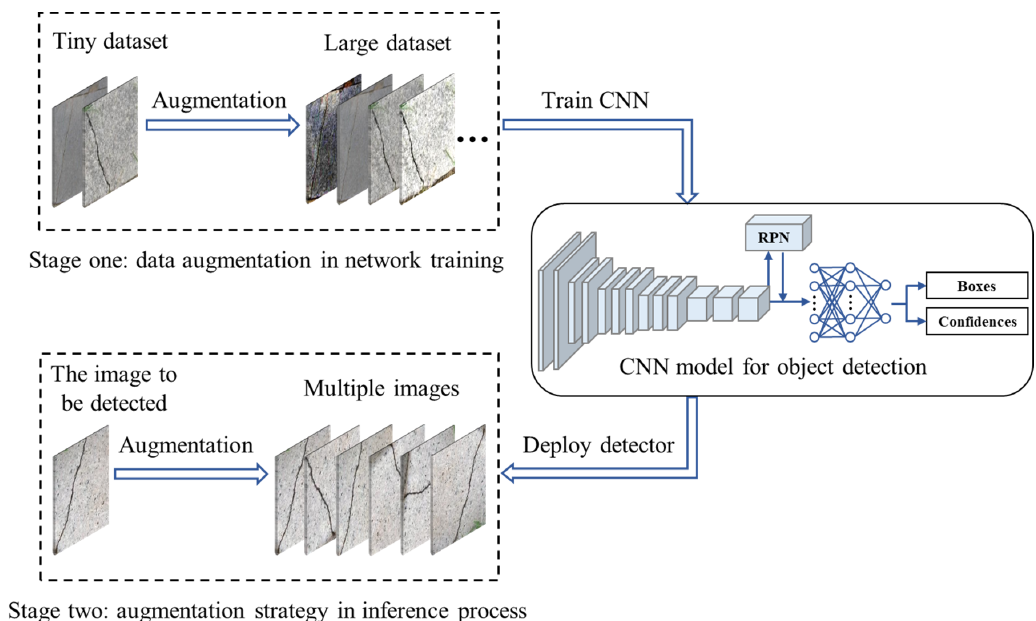
Figure 1. The completed process of our two-stage method.